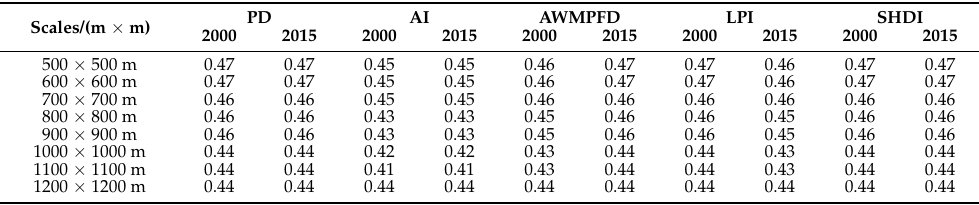
Table A2. Analysis results of spatial autocorrelation of each landscape metric in different scales in 2000 and 2015 of